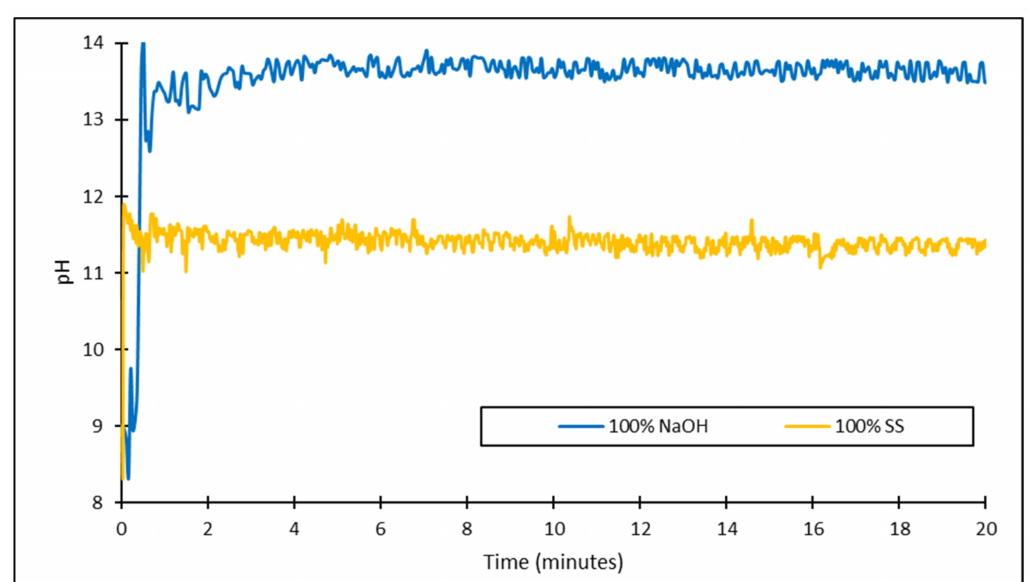
Figure 11. pH curves of fresh geopolymer pastes.